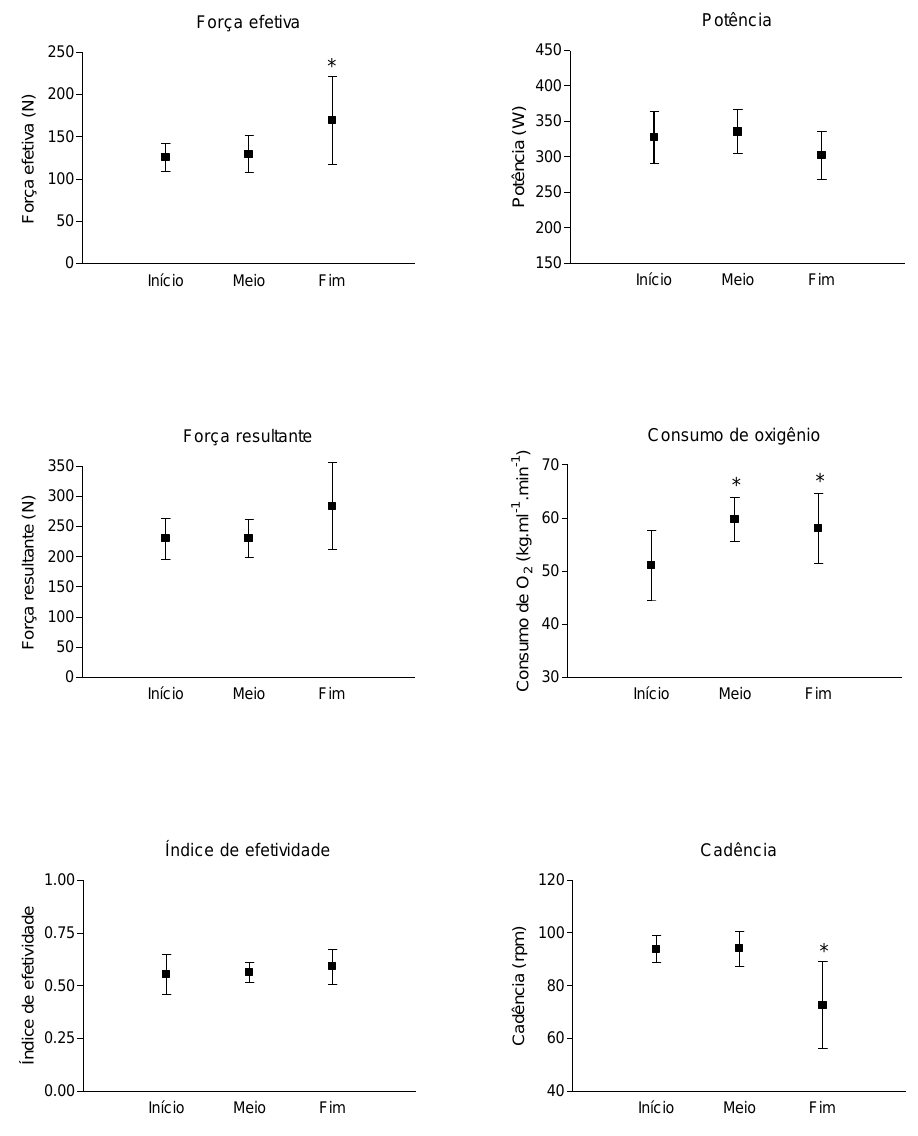
Figura 1. Médias e os desvios-padrão da força efetiva, força resultante, índice de efetividade, potência, consumo de oxigênio e cadência nos três instantes (início, meio e fim) do teste de carga constante (N=8). *diferença significativa em relação ao início do teste